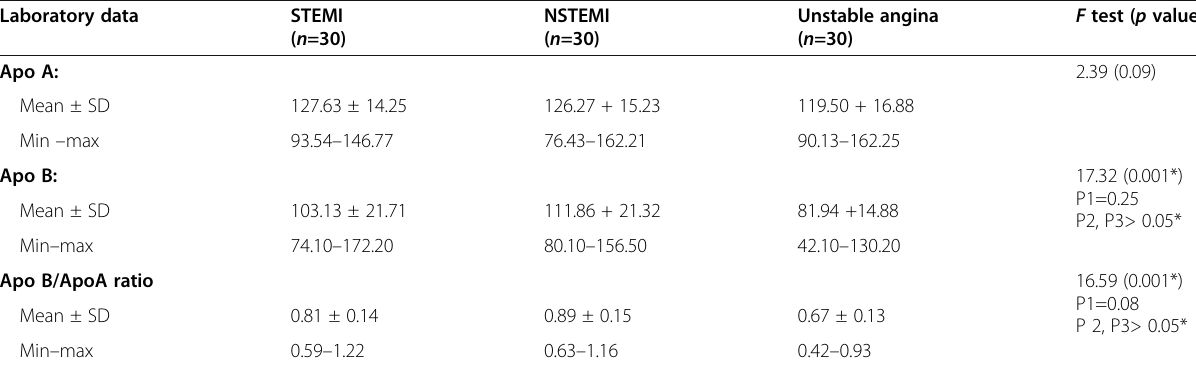
Table 3 Laboratory data of the studied groups Laboratory data